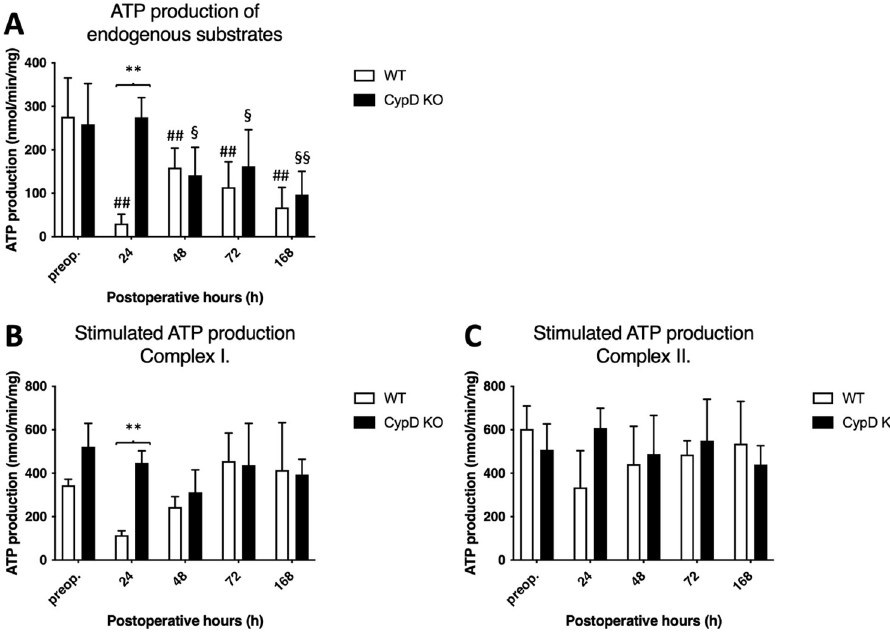
Fig 1. Alterations of adenosine 5 0 -triphosphate (ATP) production. Endogenous (A) and exogenous substrate (complex I: Glutamate-malate complex II: Succinate) stimulated (B and C) ATP production preoperatively (preop., 0 h), and at 24 h, 48 h, 72 h, and 168 h after Associating Liver Partition and Portal vein ligation for Staged hepatectomy (ALPPS) (N = 6 per time point per group). � P < 0.050, �� P < 0.0010 versus wild type (WT); # P < 0.050, ## P < 0.001 WT versus corresponding controls (preop.); § P < 0.050, §§ P < 0.0010 CypD KO versus corresponding controls (preop.). Statistical analysis was performed with a two-way ANOVA and Tukey’s post hoc test.